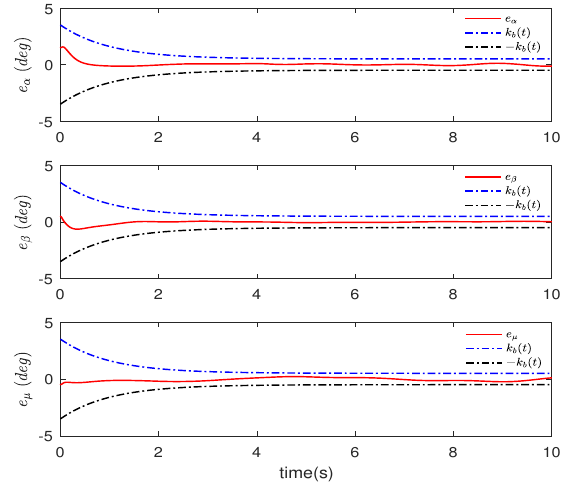
Figure 6. Constrained tracking error response curves of attitude angles.